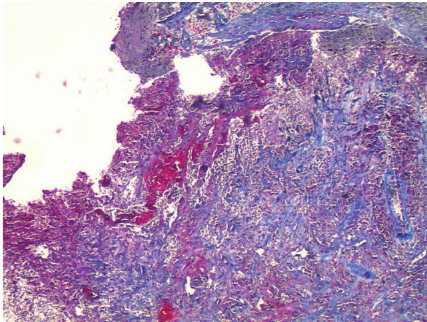
Figure 9: Biopsy of the brain lesion showing vascular prolifera- tion and reticulin and collagen deposition within necrotic tissue (Trichrome stain, magnification ×